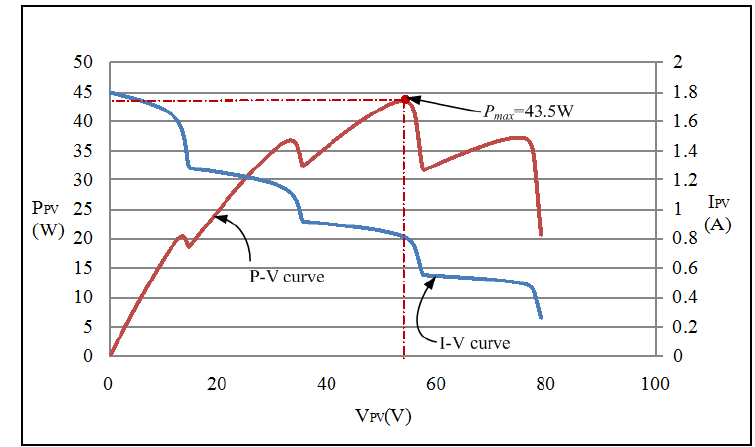
Figure 10. I–V and P–V characteristic curves of the four-serial and one-parallel module array with 0%, 30%, 50%, and 70% shading.